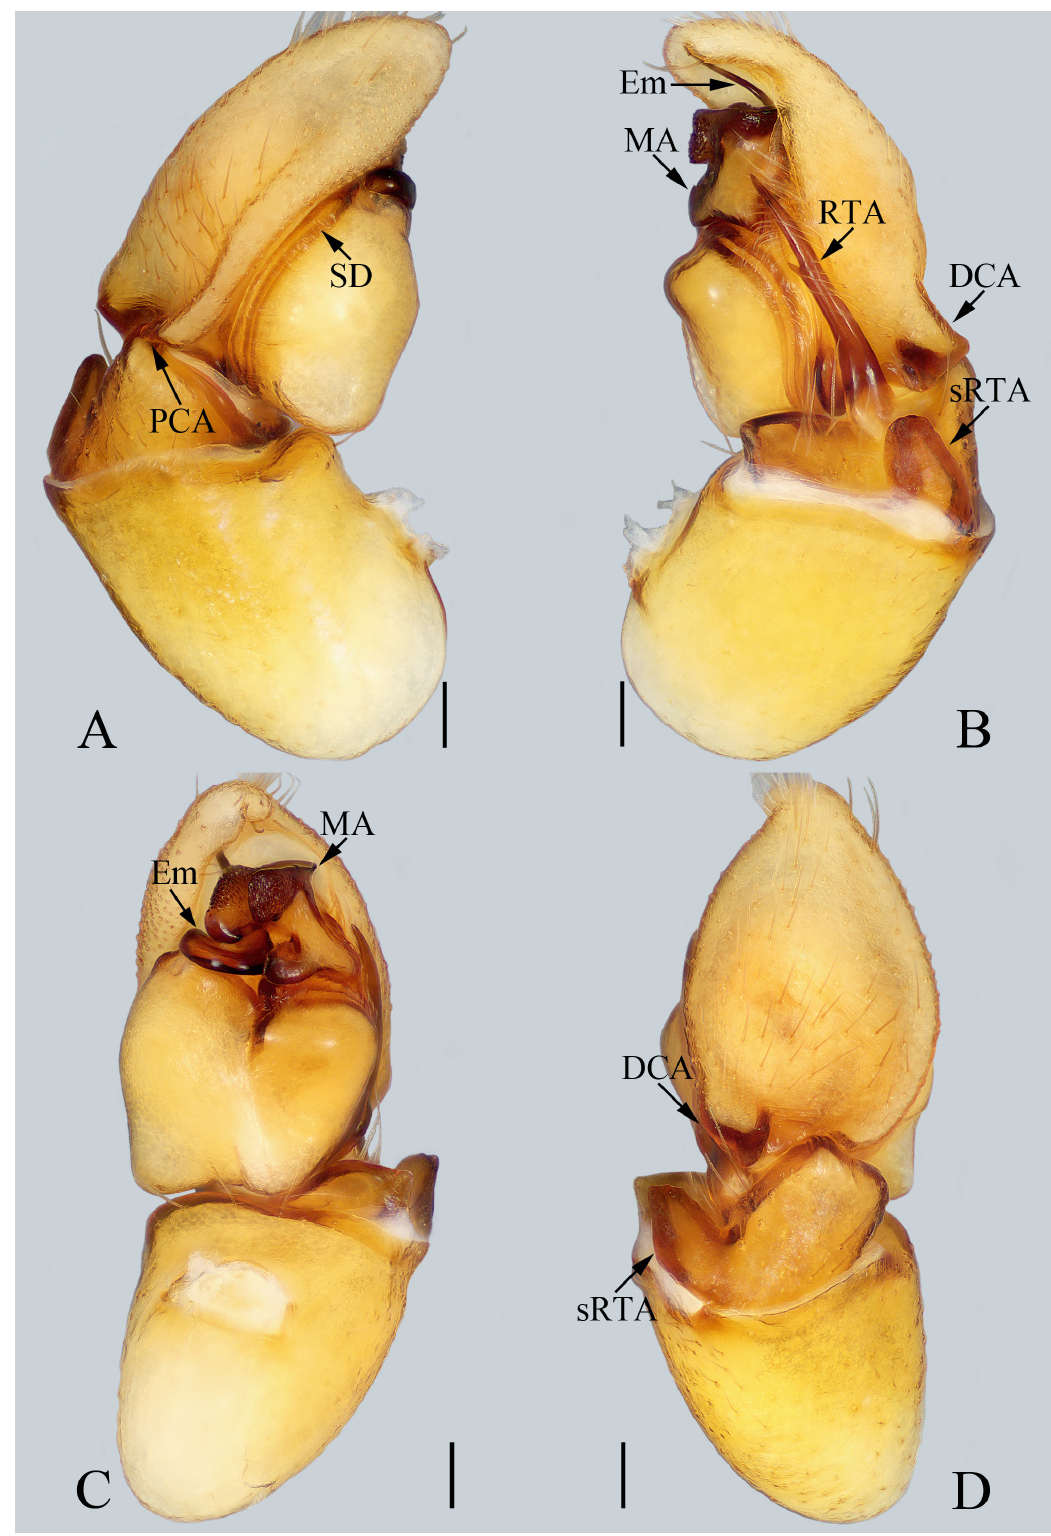
Fig. 3. Male palp of Synagelides forkiforma Yang, Zhu & Song, 2007 (HNU-20040428-01). A . Prolateral view. B . Retrolateral view. C . Ventral view. D . Dorsal view. Abbreviations: see Material and methods. Scale bars = 0.1